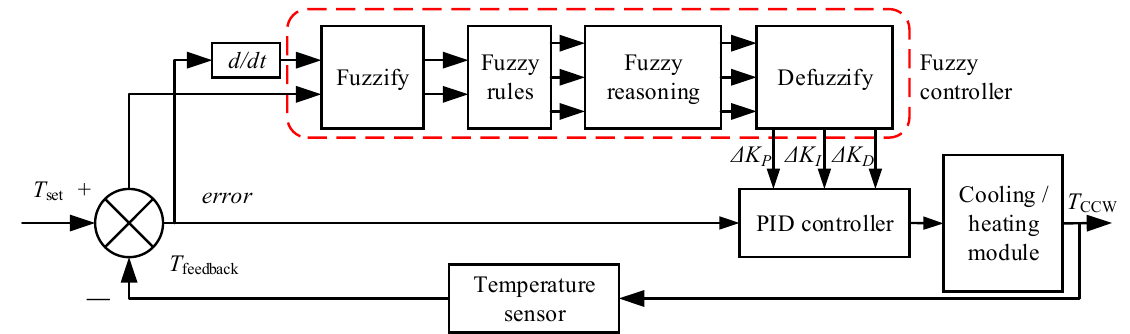
Figure 9. Schematic diagram of Fuzzy Proportion Integration Differentiation (Fuzzy-PID) introduced in the enhanced CCW machine.